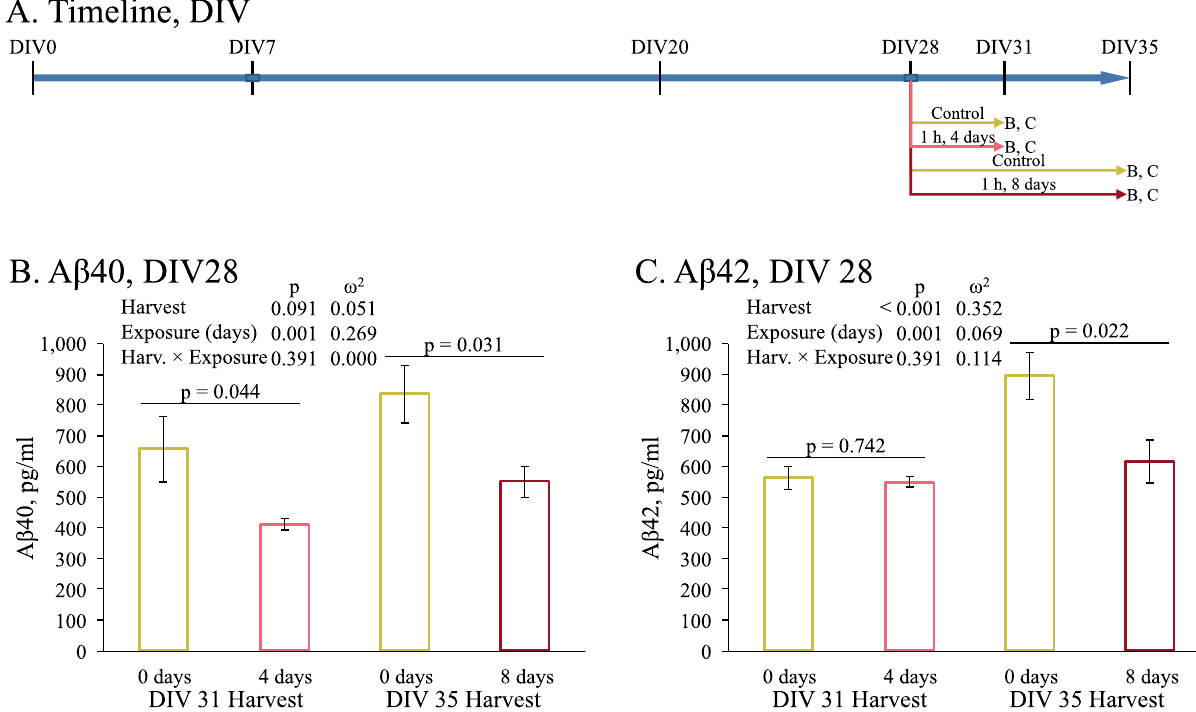
Figure 4. Effect of REMFS on levels of Aβ40 and Aβ42 in human brain cultures at DIV28. Cultures were exposed to REMFS as described in the text ( A ) Schedule of cell growth and treatments for data presented in figure. ( B ) Both culture age (28 + 4 vs 28 + 8 days) and EMF treatment produced significant differences in Aβ40 levels. However, the effect of REMFS treatment was the same regardless of culture age. ( C) Both culture age (28 + 4 vs 28 + 8 days) and REMFS treatment produced significant differences in Aβ42 levels. However, the effect of REMFS treatment significantly differed by culture age. Reduction only appeared in the oldest cultured